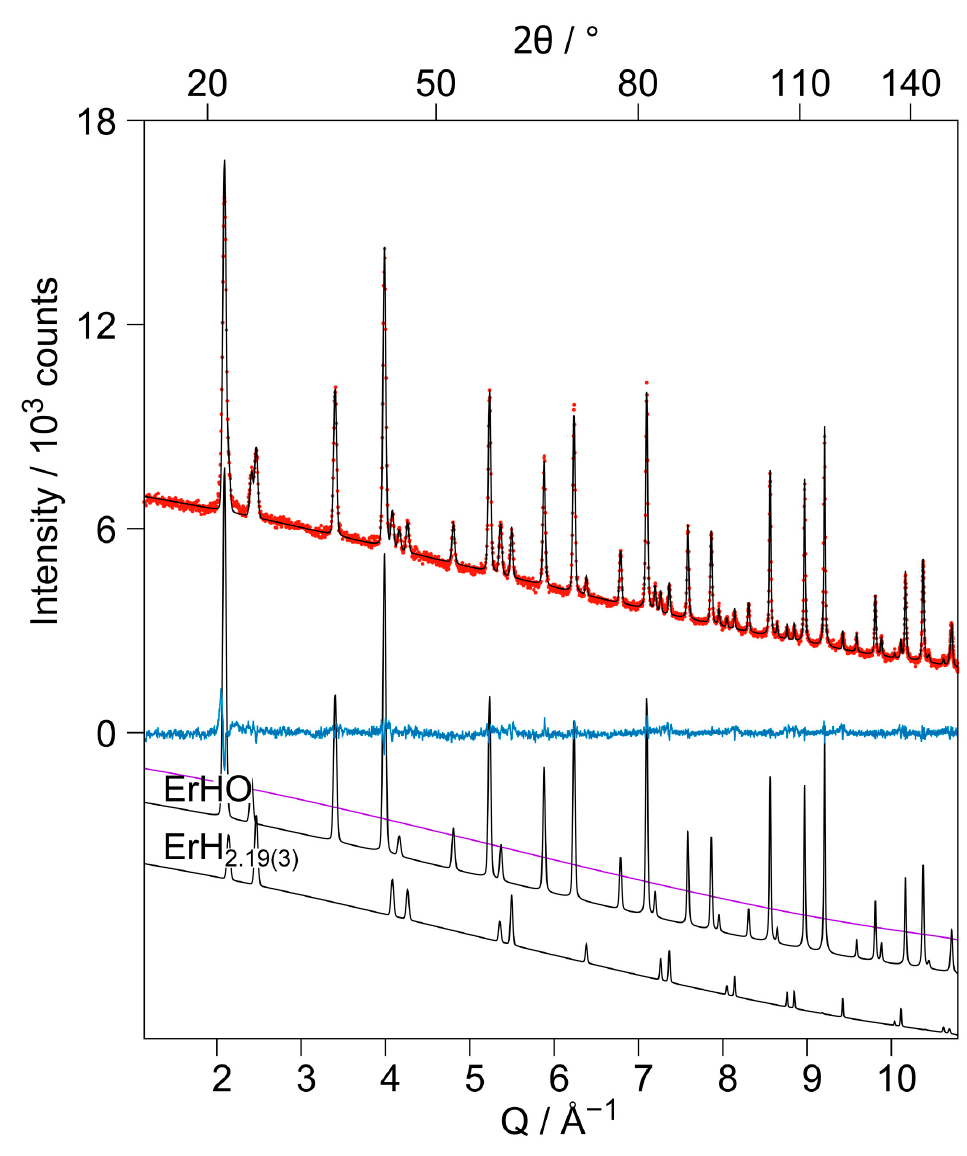
= 6.7%, a = 5.24615(7) Å), F 2